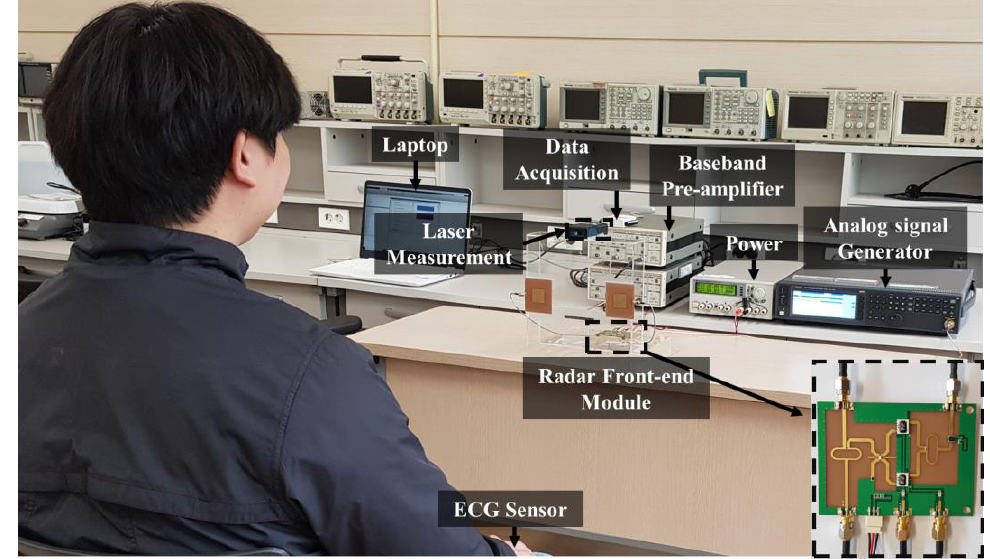
Figure 8. Measurement setup for detecting the distance and vital signs using the proposed FSK radar. Table 1. Information relevant to the subjects.